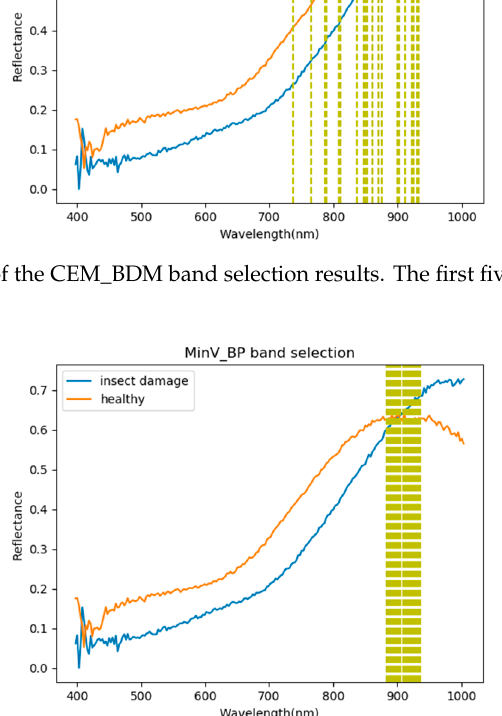
Figure 11. Visualization of the MinV_BP band selection results. The first five bands are 936, 933, 927, 930, and 925 nm.